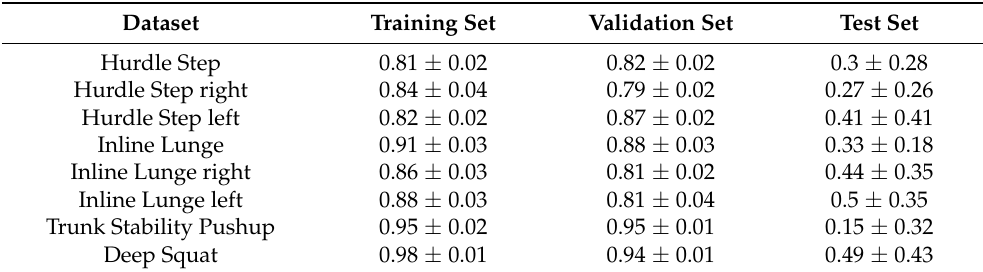
Table 4. Results of the evaluation of the proposed approach on unknown subjects. For each dataset a 10-fold LOSOCV is performed and the arithmetic mean of the weighted F1-scores of training, validation and test set is shown, together with the corresponding standard